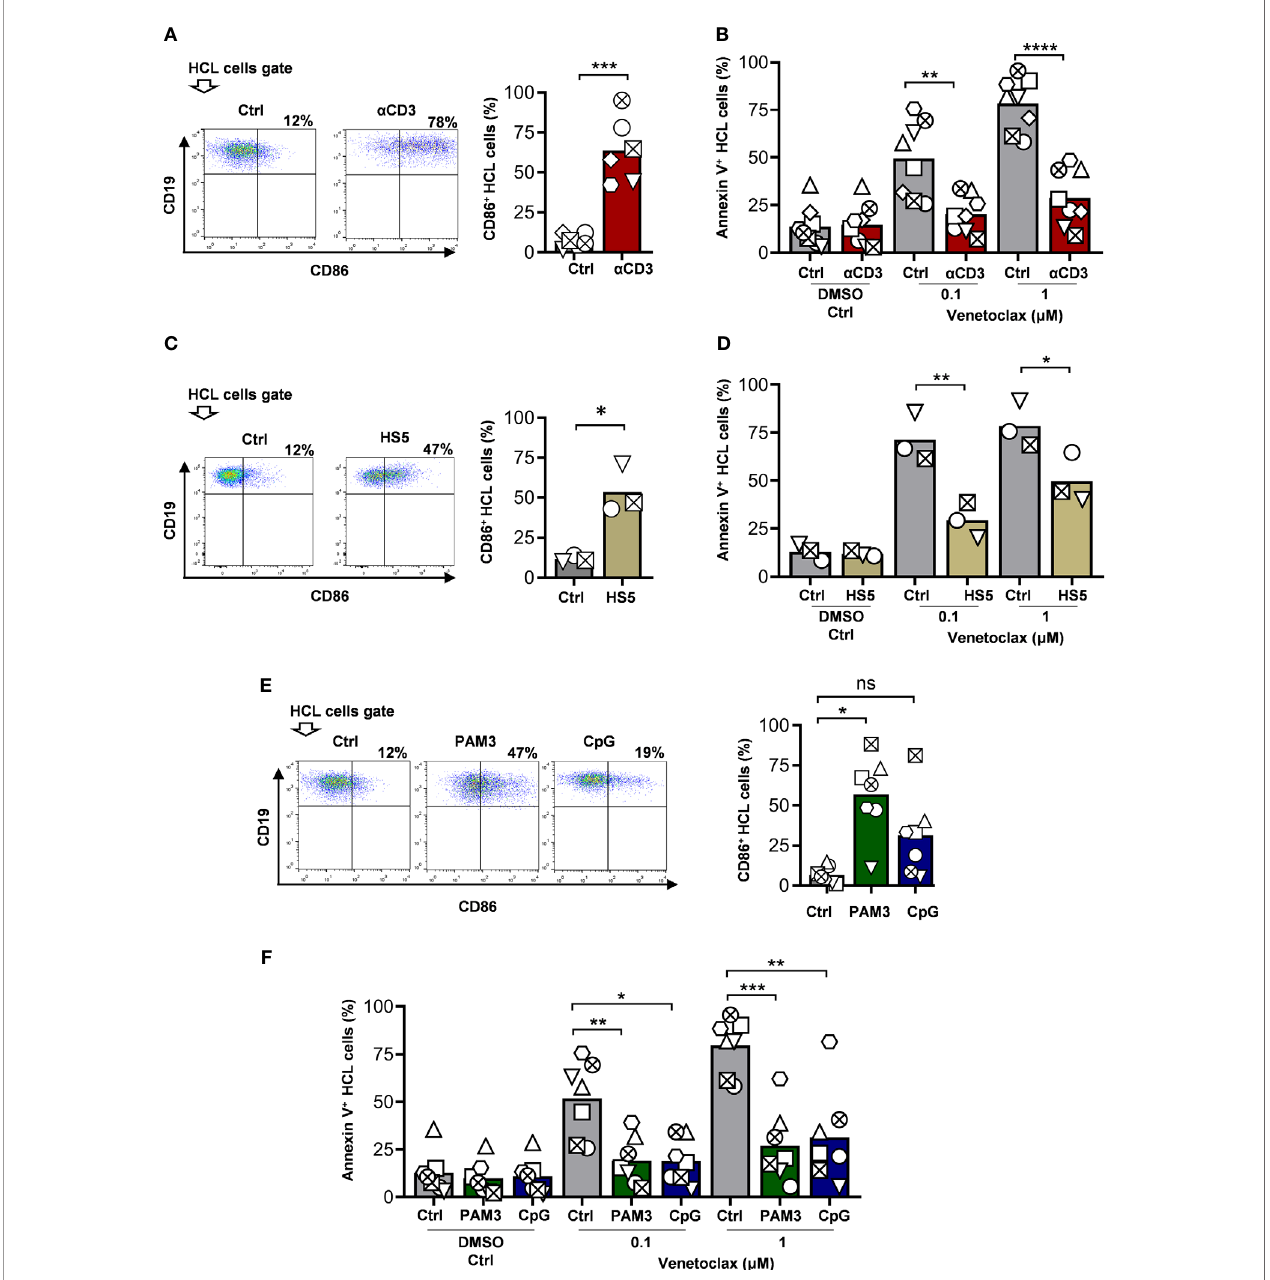
FIGURE 2 | Activation of HCL cells confers resistance to venetoclax-induced cell death. (A) PBMCs from HCL patients were incubated with medium alone (Ctrl) or on anti-CD3-coated wells (25 ng). At 48 h, cells were labeled with anti-CD19 and anti-CD86. Shown are representative dot plots (left) and mean values (right) for n = 6 samples (two-tailed paired t- test). (B) PBMCs from HCL patients were incubated with medium alone (Ctrl) or on anti-CD3-coated wells for 24 h. Then venetoclax (0.1 or 1uM) or 0.01% DMSO as vehicle was added for additional 24 h. HCL cell death was analyzed by fl ow cytometry as described in the legend of Figure 1 . Shown are the results for the entire cohort (n = 8). (C) PBMC from HCL patients were co-cultured with HS-5 stromal cells for 48 h and labeled with anti- CD19 and anti-CD86. Shown are representative dot plots (left) and mean values (right) for n = 3 (two-tailed paired t- test). (D) PBMCs from HCL patients were co- cultured with HS-5 for 48 h. Then venetoclax (0.1 or 1uM) or 0.01% DMSO as vehicle was added for additional 24 h, and HCL cell death was analyzed as described above. (E) PBMCs from HCL patients were incubated with medium alone (Ctrl) or in the presence of PAM3 (300 ng/ml) or CpG (5 m M). At 48 h, cells were labeled with anti-CD19 and anti-CD86. Shown are representative dot plots (left) and mean values (right) for n = 7. (F) PBMCs from HCL patients were incubated with medium alone (Ctrl) or in the presence of PAM3 (300 ng/ml) or CpG (5 m M) for 24 h. Then venetoclax (0.1 or 1uM) or 0.01% DMSO as vehicle was added for additional 24h and HCL cell death was analyzed as described above. Shown are the results for the cohort studied (n=7). For all the group graphics, each symbol represents a single patient and paired one-way ANOVA followed by multiple comparisons were performed unless otherwise indicated (*p < 0.05, **p < 0.01, ***p < 0.001, ****p < 0.0001, ns, not signi fi